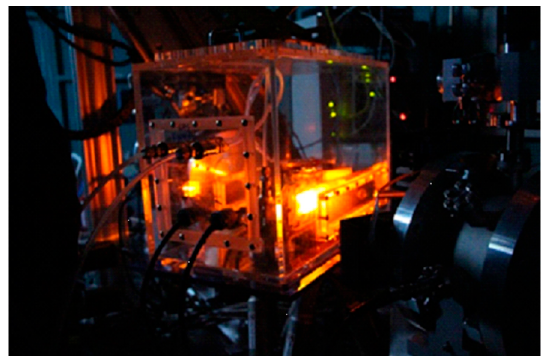
Figure 1. High-T in situ experiment at INE-Beamline with micro-furnace cell inside a plexiglass box acting as second containment during Am L3 fluorescence XAFS detection in March 2014 (cooperation with CEA Cadarache, France [14]).